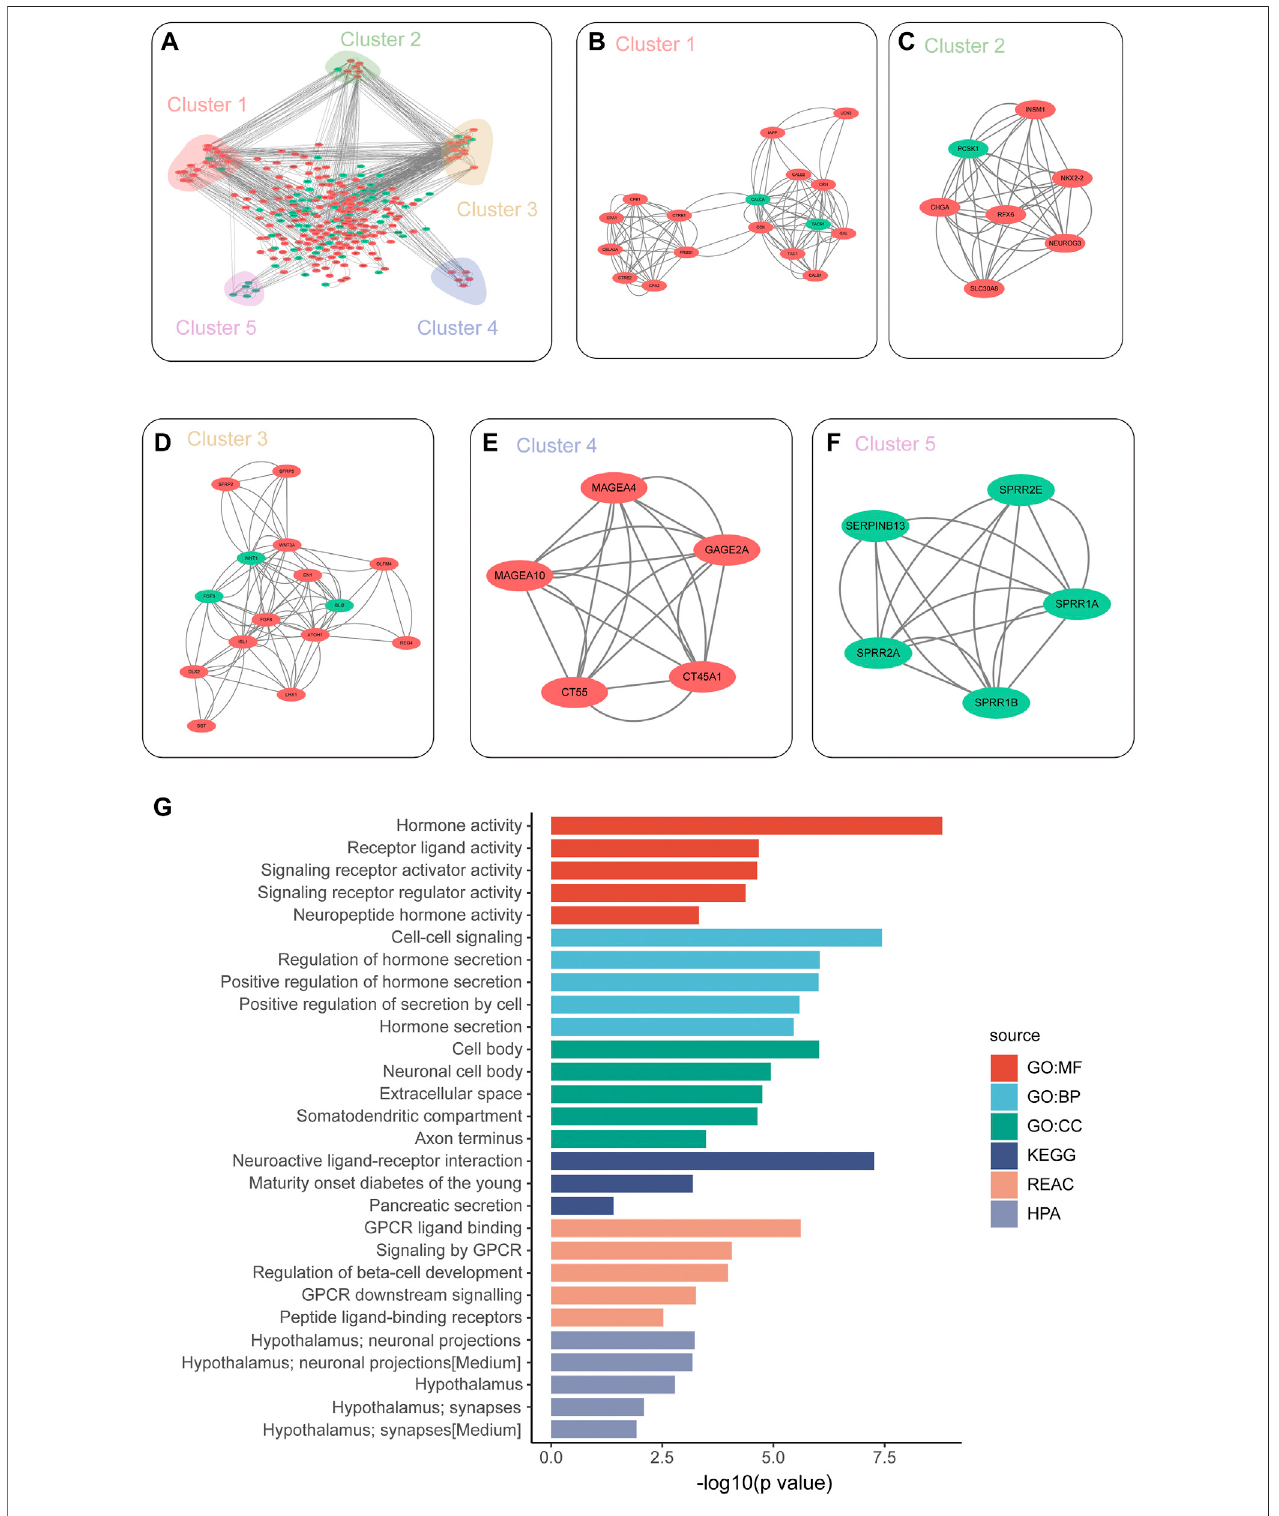
FIGURE 5 | Protein – protein interaction (PPI) analysis predicts possible molecular therapeutic targets. (A) Network diagram shows the DEG protein – protein interaction network between the PBhiPMhi group and PBloPMlo group; (B – F) network diagram shows the fi ve sub-networks of MCODE plug-in mining. (G) Functional enrichment analysis on these 20 hub genes in three